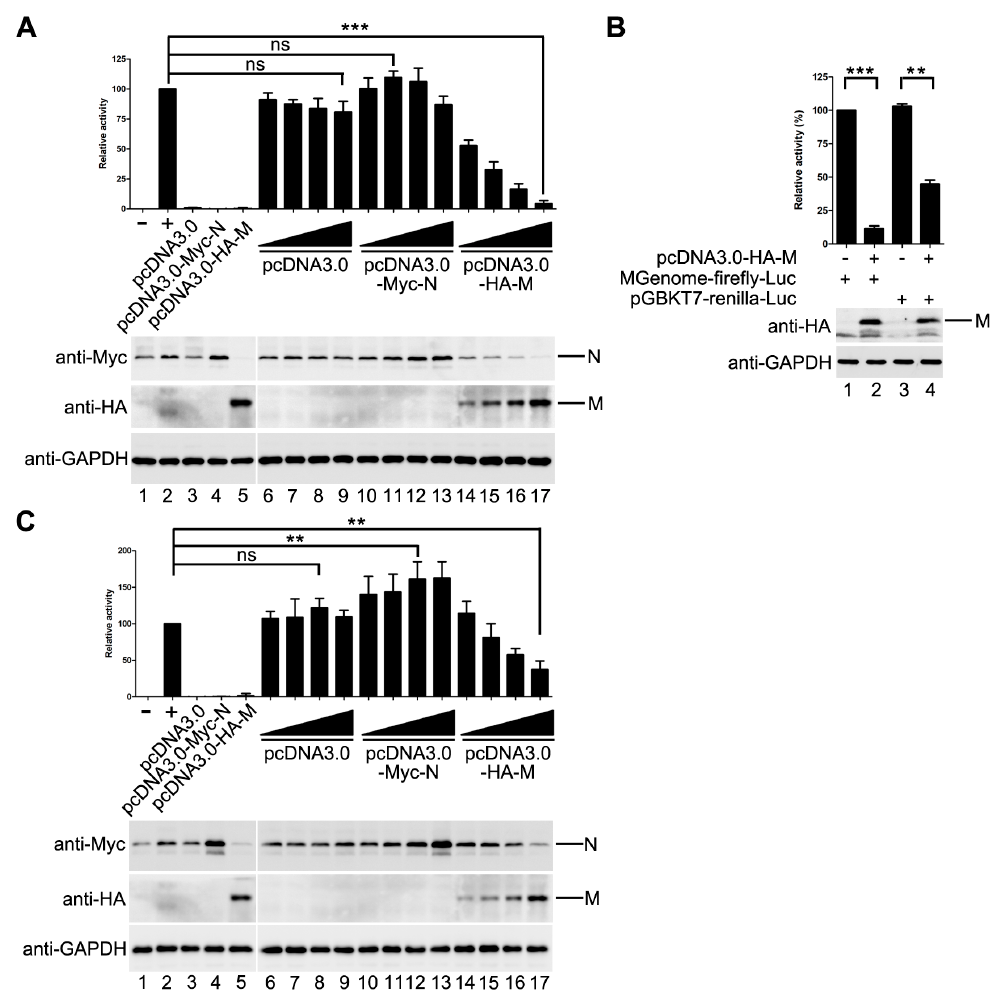
Figure 1. M decreases minigenome reporter activity. ( A ) the effect of M on minigenome-encoded reporter RNA synthesis. vTF7-3-infected HeLa cells were transfected with plasmids encoding N (125 ng), P (62.5 ng), L (100 ng) and minigenome (50 ng) and increasing amounts of pcDNA3.0 vector or plasmids encoding M and N (100, 200, 400, 800 ng). The amount of plasmids was kept constant by pGBKT7. Relative luciferase activity was measured according to the manufacturer’s instructions. The expression of M and N were detected via Western blot with anti-HA and anti-Myc antibody respectively. GAPDH was used as a loading control. Values are means ± SD from three experiments; Student’s t test: *** p < 0.001, ns = not significant. “+, − ” means with or without transfecting P plasmid. ( B ) M has an effect on the expression of T7-promoter driven renilla luciferase. Plasmid encoding renilla luciferase (5 ng) and plasmids encoding N, P, L and minigenome were transfected alone or together with 800 ng pcDNA3.0-HA-M in vTF7-3-infected HeLa cells. Relative luciferase activity was measured and the expression of M was detected via Western blot with anti-HA antibody.Values are means ± SD from three experiments; Student’s t test: ** p < 0.01, *** p < 0.001, “+, − ” means with or without transfecting corresponding plasmids. ( C ) M decreases minigenome-encoded reporter RNA synthesis. Plasmids encoding N (125 ng), P (62.5 ng), L (100 ng), minigenome (50 ng) and renilla luciferase (5 ng) were transfected with increasing amounts of of pcDNA3.0 vector or plasmids encoding M and N (100, 200, 400, 800 ng) in vTF7-3-infected HeLa cells. The amount of plasmids was kept constant by pGBKT7. The activities of firefly luciferase and renilla luciferase were measured according to the manufacturer’s instructions. Relative activity of firefly luciferase to renilla luciferase was calculated and the expression of M was detected via Western blot as described for ( A ). Values are means ± SD from three experiments. Student’s t test: ** p < 0.01, ns = not significant. “+, − ” means with or without transfecting P